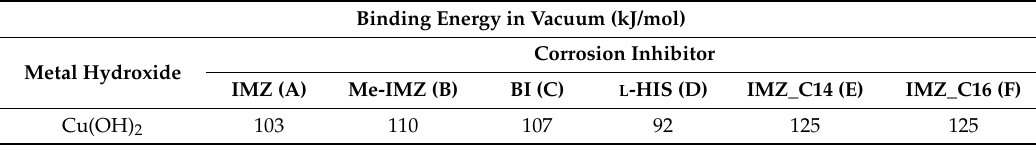
Table 1. Calculated Binding Energy of different corrosion inhibitors onto various metal hydroxide substrates in the absence of any external interaction.